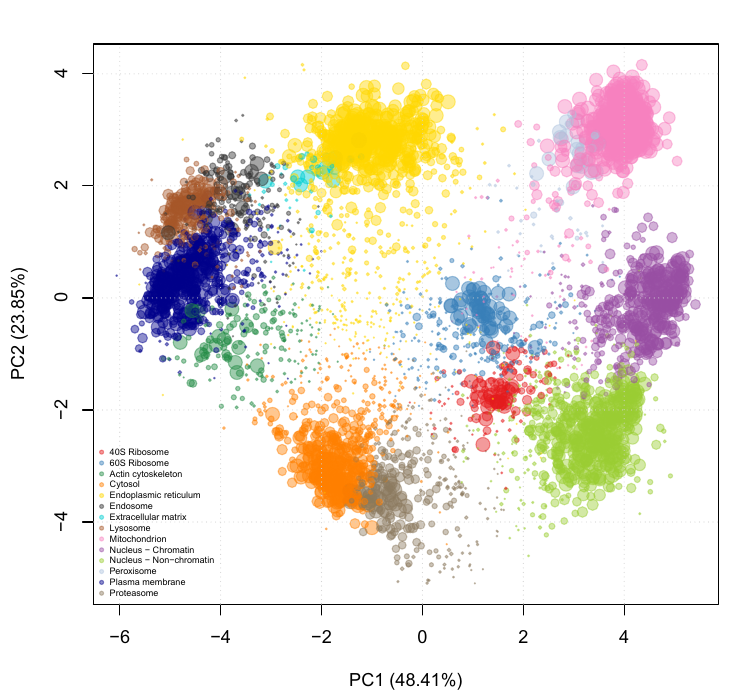
Figure 16. Classification results. Colours indicate class membership and point size are representative of the classification